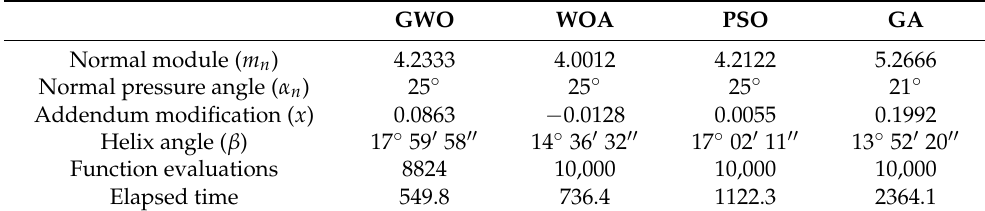
Table 7. Best solutions of the proposed algorithms for scenario I and relevant obtained input design parameters. GWO